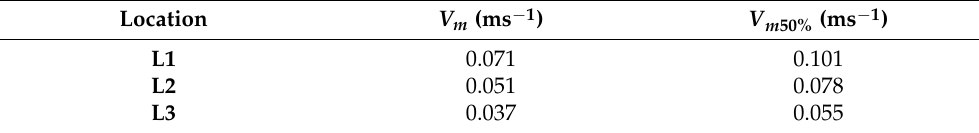
Table 1. Values of the representative site-specific velocity parameters for AR model